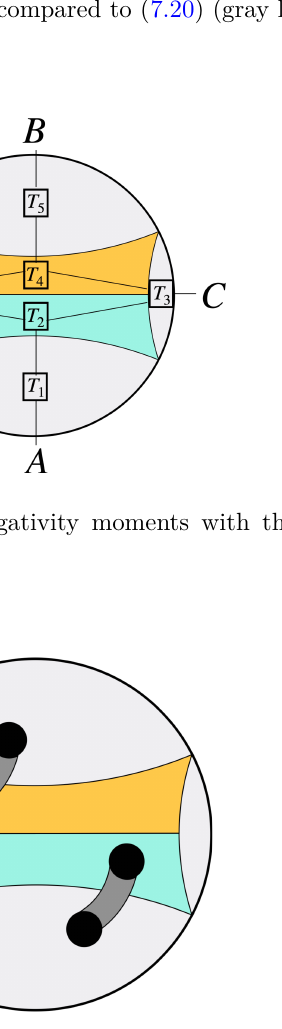
Figure 38 . Negativity spectrum at the phase transition when w 3 = 2 w 1 = 2 w 2 = 4 and N = 2 . The average of 10 realizations (black dots) is compared to (7.20) (gray line).